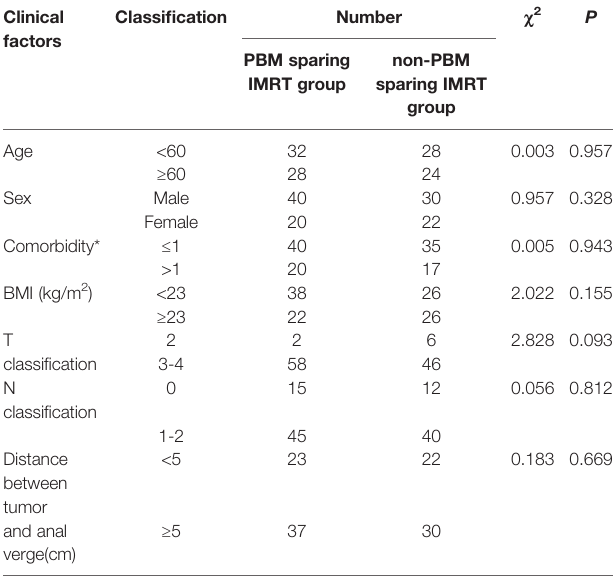
TABLE 1 | Chi-squared analysis of clinical factors for PBM sparing IMRT group and non-PBM sparing IMRT group. Clinical factors